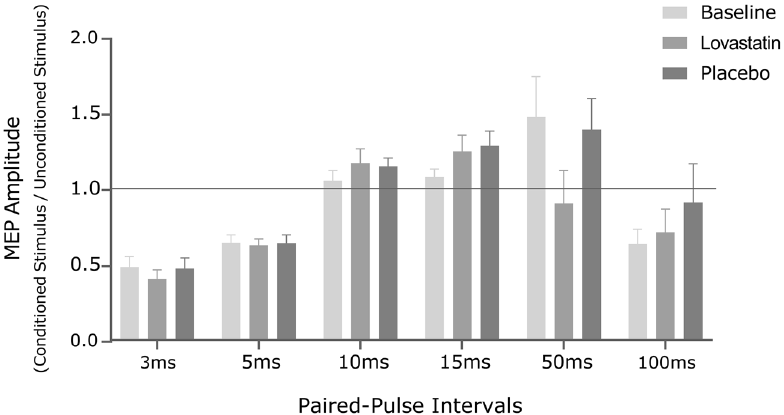
Figure 2. MEP peak-to-peak amplitude ratios for SICI3ms, SICI5ms, ICF10ms, ICF15ms, LICI50ms and LICI100ms, at baseline and after lovastatin and placebo administration. The horizontal line represents a null effect, wherein conditioned stimulus amplitude equals the amplitude from baseline pulses. Inhibition occurs for bars below the horizontal line, whereas excitation stands above the line. MEP motor-evoked potential, ms millisecond.